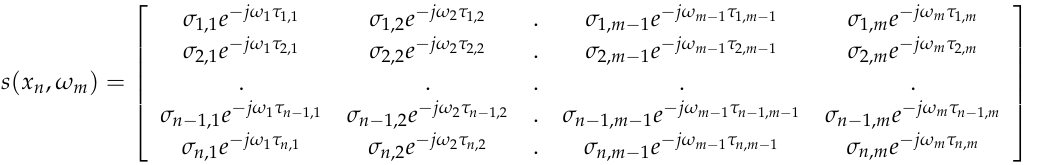
Figure 3. Photograph showing the cart with the horn antennas mounted and the wall behind which the targets were located.